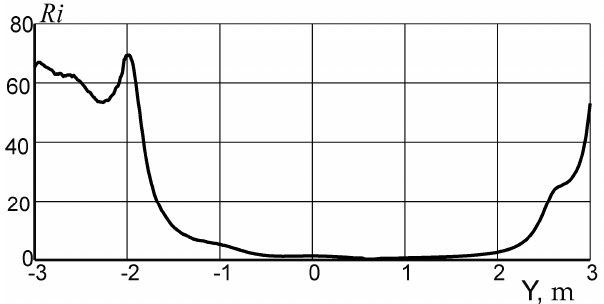
Figure 5. Distribution of the local Richardson number along the Y axis with Z = − 75 mm.